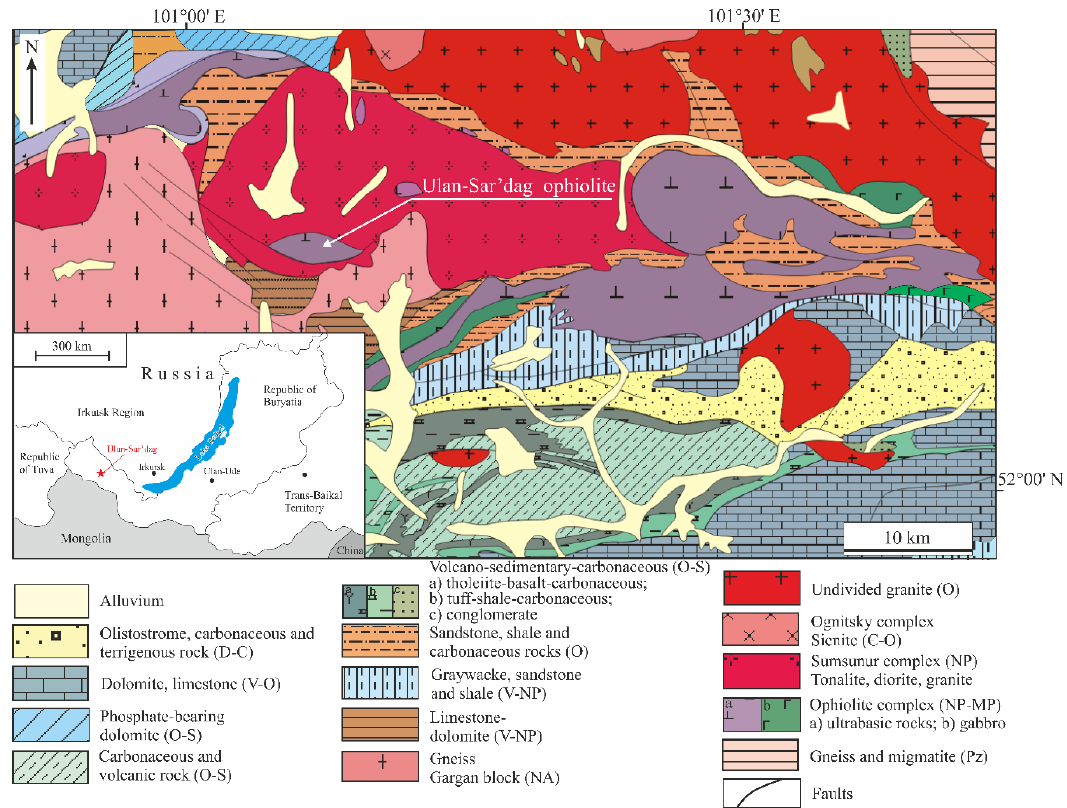
Figure 1. Geological map of the southeastern part of the Eastern Sayan region [31]. NB—northern branch, SB—southern branch.